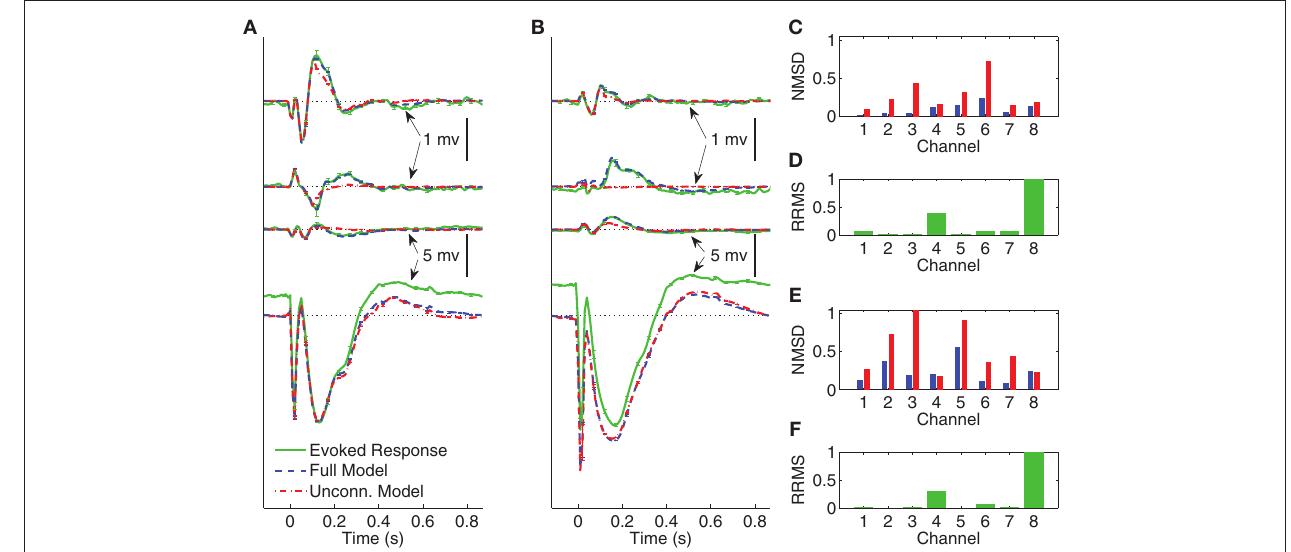
FIGURE 6 | Comparison between average CV evoked responses and average CV model responses of Subject B with two different stimulating locations in wakefulness. In panels (A) and (B) the black dotted lines indicate the origin while the error bars denote the standard error of the mean. (A) Average CV evoked and average CV model responses of channels 1, 3, 6, and 8 when the stimulating channel is L1. (B) Average CV evoked and average